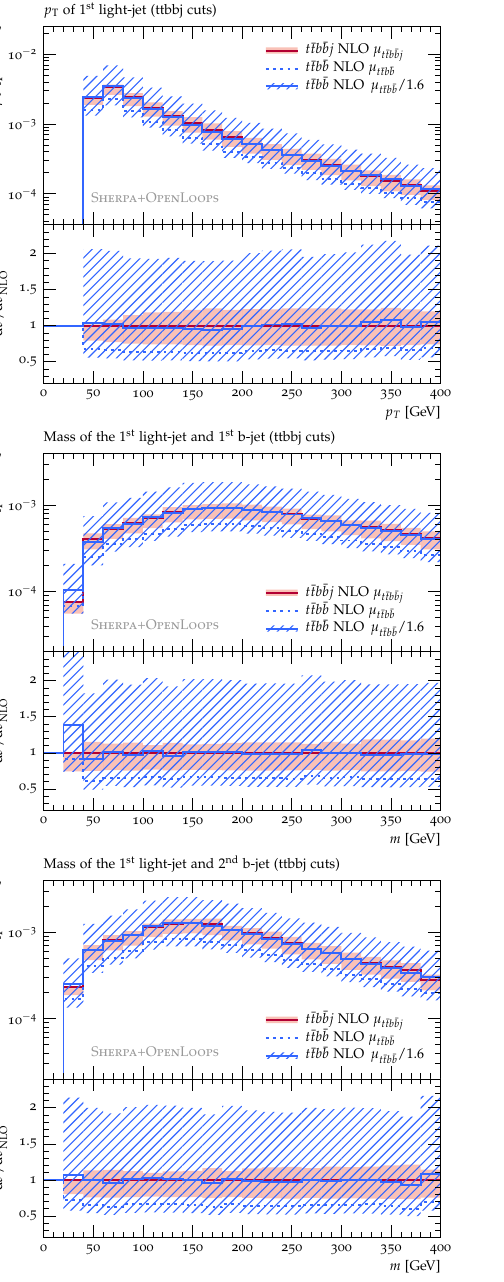
Figure 19. Distributions in the p T of the leading jet and the mass of light-jet- b -jet systems in the ttbbj phase space. Comparison of NLO t (cid:22) tb (cid:22) bj predictions with default scale choice, ( (cid:22) R ; (cid:22) F ) = ( (cid:22) ; H T = 2), to NLO t (cid:22) tb (cid:22) b predictions with ( (cid:22) R ; (cid:22) F ) = ( (cid:20) (cid:22) ; (cid:20) H T = 2). In the left plots, the t (cid:22) tb (cid:22) bj t (cid:22) tb (cid:22) b reference curves for the matching procedure (solid, labelled NLO) correspond to the above central scales, and the applied rescaling factor is (cid:20) = 1 = 1 : 6. In the right plots, the reference curves (solid, labelled NLO) are the average values of the scale-variation bands, and (cid:20) = 1 = 1 : 14. The blue dashed curves indicate the position of the NLO t (cid:22) tb (cid:22) b reference prediction before tuning, while all other NLO t (cid:22) tb (cid:22) b predictions and scale-variation bands correspond to the tuned